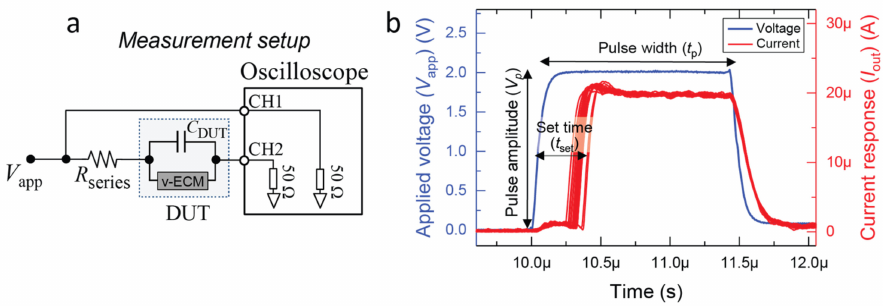
Figure 6. ( a ) The measurement setup used to perform all transient pulsed measurements in this work. ( b ) Typical transient current response of an Ag/HfO 2 /Pt device under a 2.00 V/1.5 µ s programming pulse. A 100 k Ω series resistor ( R series ) was used to limit the maximum